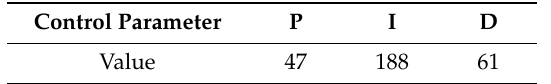
Table 4. The employed control parameters to implement the feedback system.